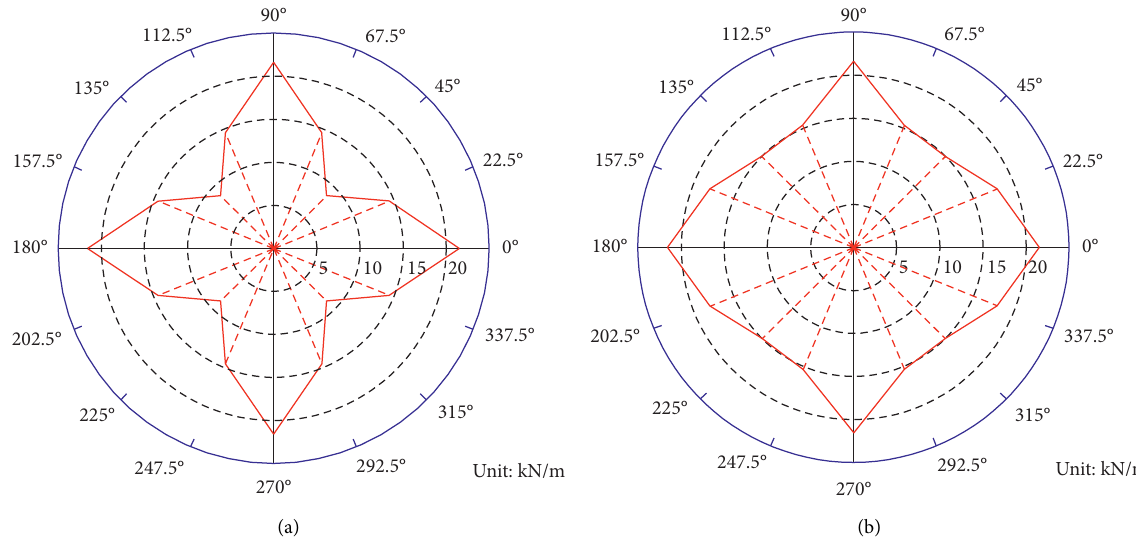
Figure 2: Comparison of ultimate tensile strength in different loading directions. (a) Biaxial geogrid (SS20). (b) Triaxial geogrid (TX160).